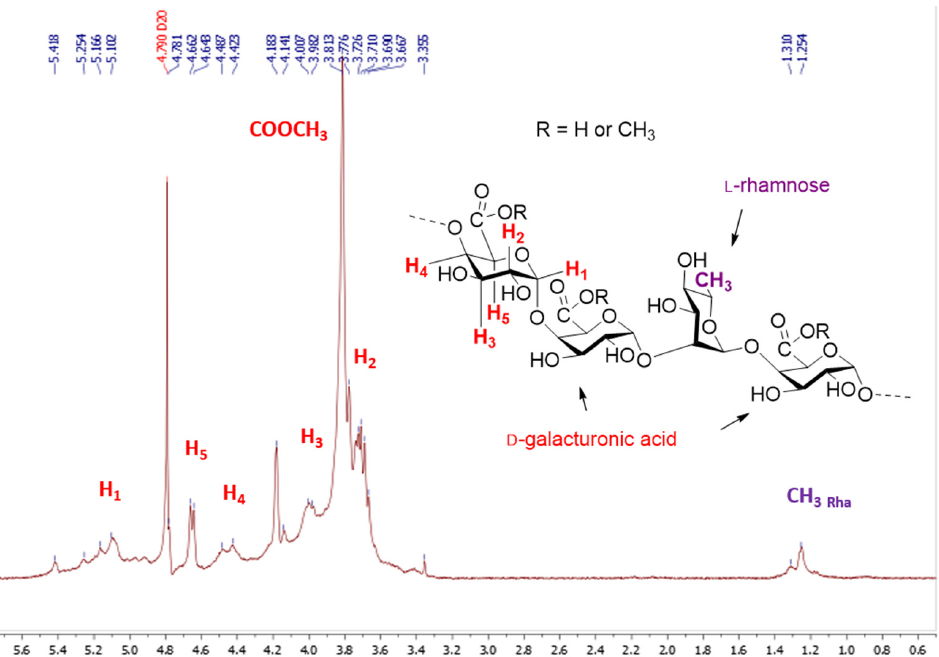
Figure 3. 1 H NMR (400 MHz) spectrum in D 2 O of the pectin.